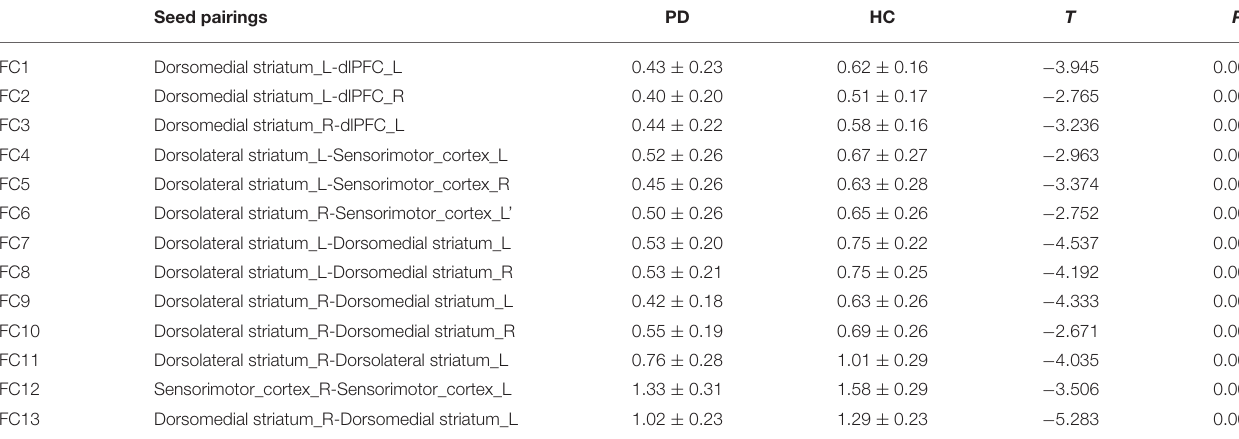
TABLE 2 | Functional connectivity strength comparisons between PD and HC.